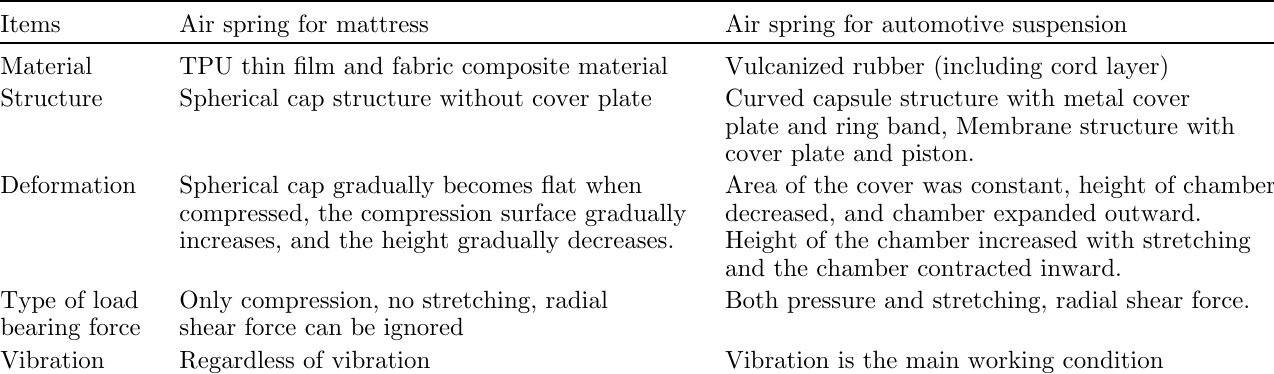
Table 3. Compare with air spring in automotive